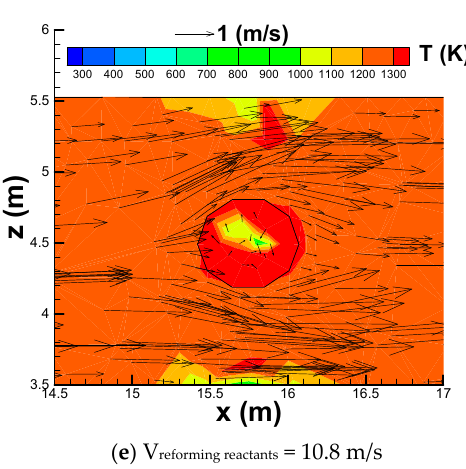
Figure 11. Comparison of the temperature and velocity vector distributions at y = 6 m around a reforming tube using different inlet velocities of the reforming reactants.